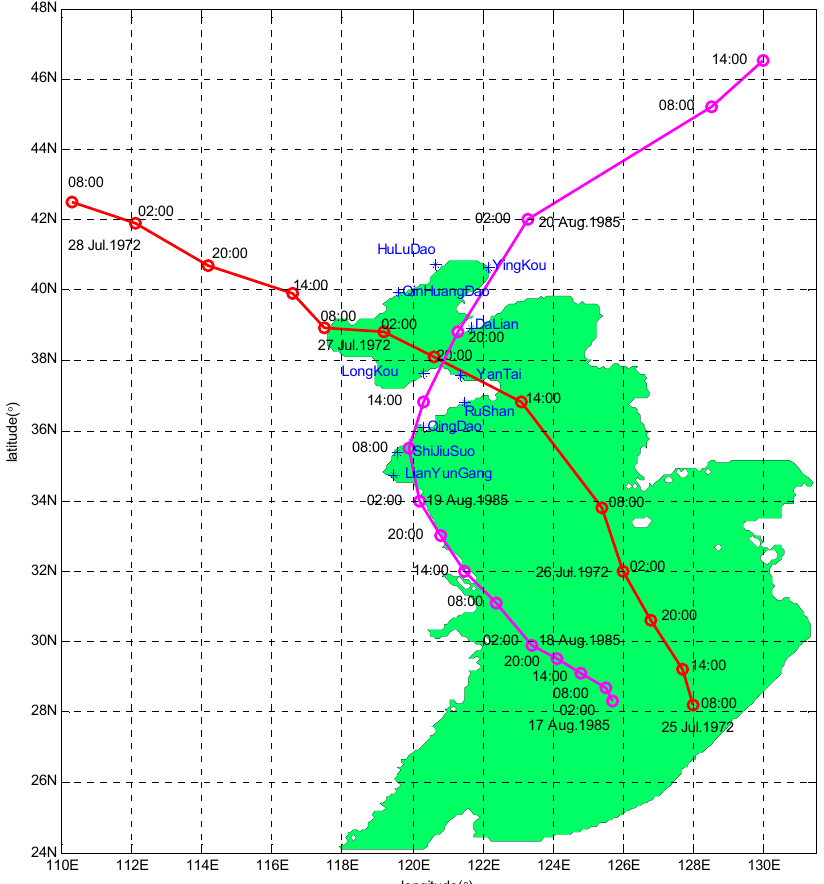
Figure 1. Tide stations and trajectories of Typhoons 7203 and 8509. Blue asterisks denote the locations of tide stations. Red and mauve solid lines are the trajectories of Typhoons 7203 and 8509 respectively. Red and mauve circles indicate time.